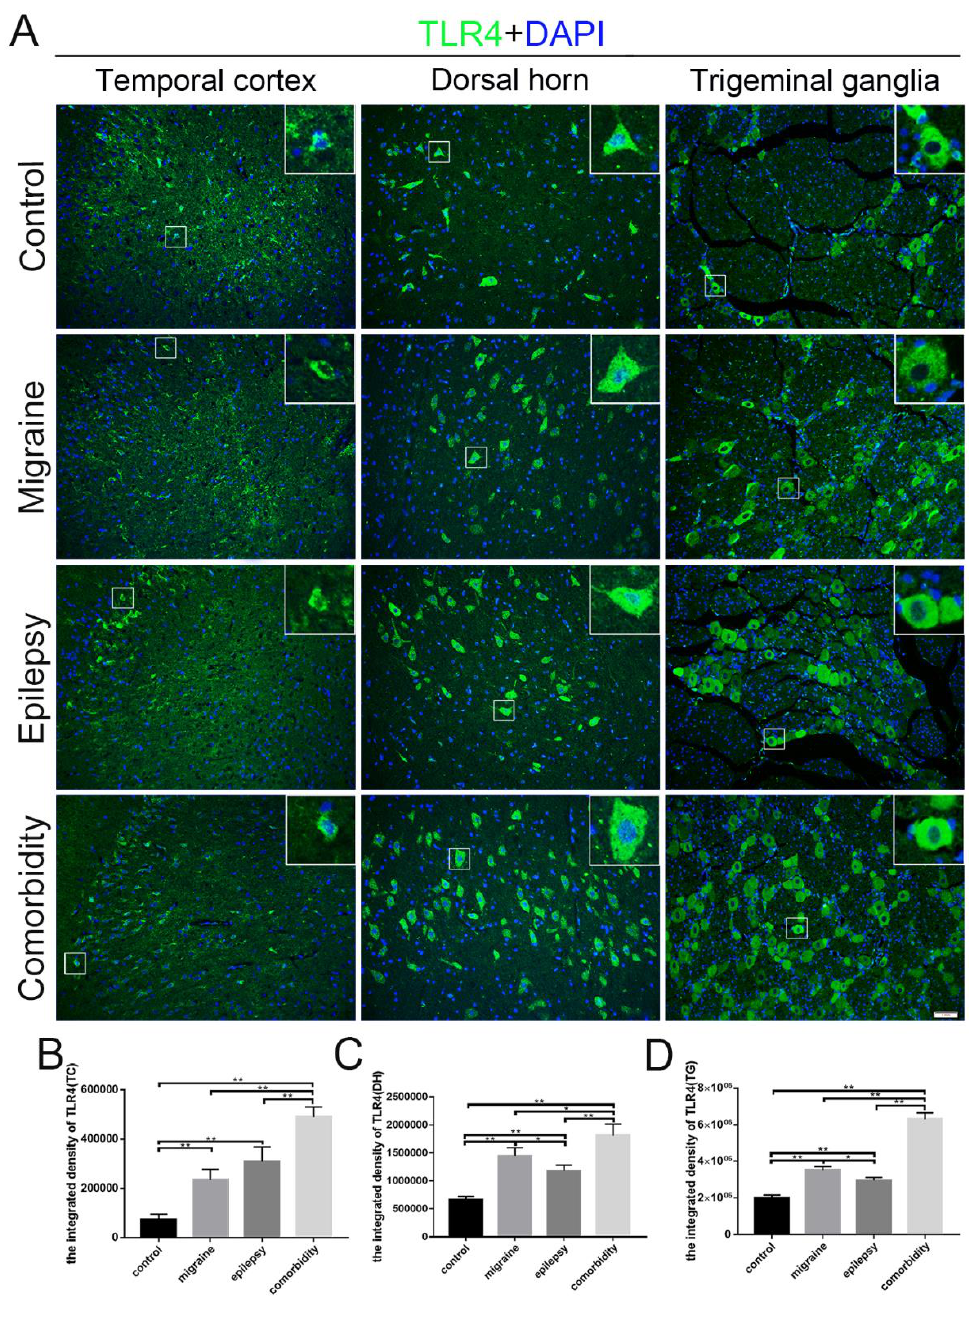
Figure 4. Localization of TLR4 in the temporal cortex, medullary dorsal horn, and trigeminal ganglion in four groups. ( A ) TLR4 (green) localized in the temporal cortex, medullary dorsal horn, and trigeminal ganglion in four groups. TLR4 was expressed in some cytoplasms (( A ), magnifying cells). ( B – D ) Quantitative assessment of the integrated density of TLR4 in temporal cortex ( B ), medullary dorsal horn ( C ), and trigeminal ganglion ( D ) ( n = 3, * p < 0.05, ** p < 0.01). DAPI (blue) indicates cell nuclei. The scale bar represents 50 µm. TC: temporal cortex, DH: medullary dorsal horn, TG: tri- geminal ganglion.